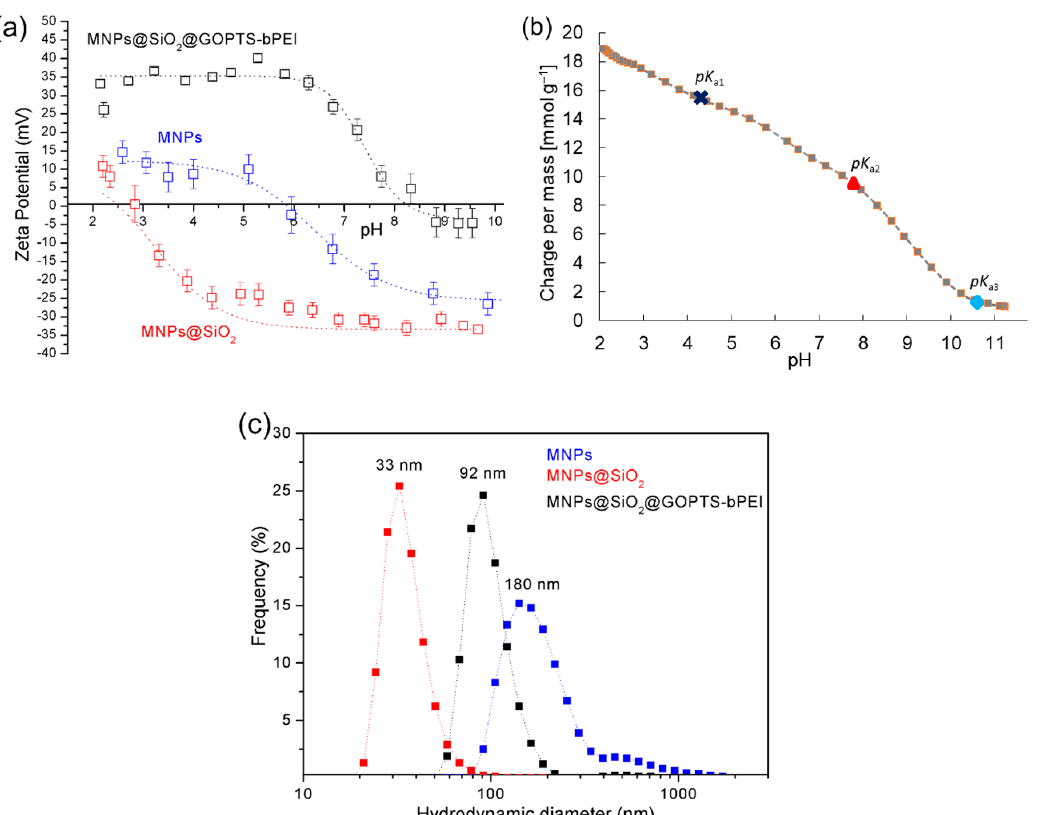
Figure 5. Zeta Potential measurement as a function of pH for SiO 2 -coated MNPs and the same one functionalized with the GOPTS-bPEI ( a ); pH-depended potentiometric titration versus pH for pure hyper-branched polyethyleneimine (bPEI) ( b ) and number-sized distribution of hydrodynamic diameter at pH = 6 in aqueous media ( c ).